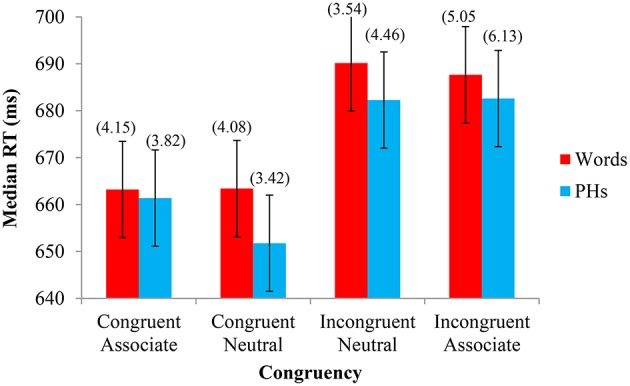
Experiment 2—Color associated stimuli: Median response time (RT) and percent errors (above) in naming the font color as a function of Letter String Type (word, PH) and Congruency (congruent, neutral congruent, neutral incongruent, incongruent). The 95% confidence intervals (shown here for RT by the error bars attached to each data point) indicate that, for word stimuli, there is no difference in the time taken to respond to congruent color words and congruent neutral words and there is also no difference between incongruent color and incongruent neutral words. For PH stimuli, there is no difference in RTs between congruent neutral and congruent color words, or between incongruent neutral and incongruent color words. The percent error confidence interval was ± 1.34%. Paired-samples t-tests support the 95% CIs for Experiment 2, whereby if the CIs reflected a significant difference, so too did the t-tests, all t's(23) > 3.815, p's < 0.002.